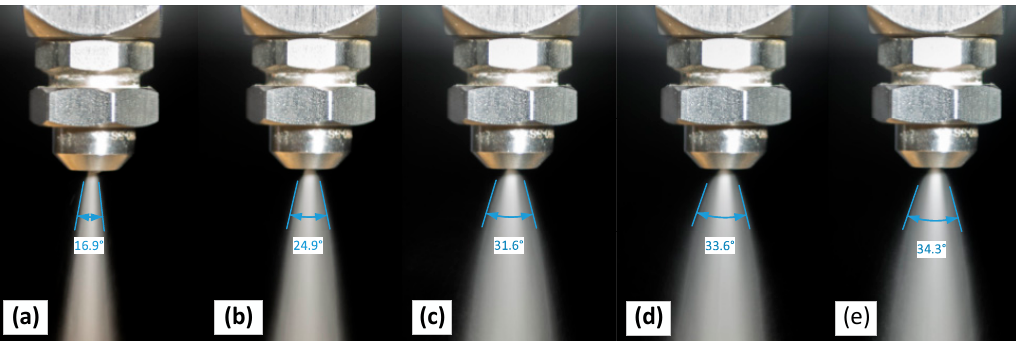
Figure 3. Photographic view of the practical 1/4J Set-Up Air Atomizing Nozzle.